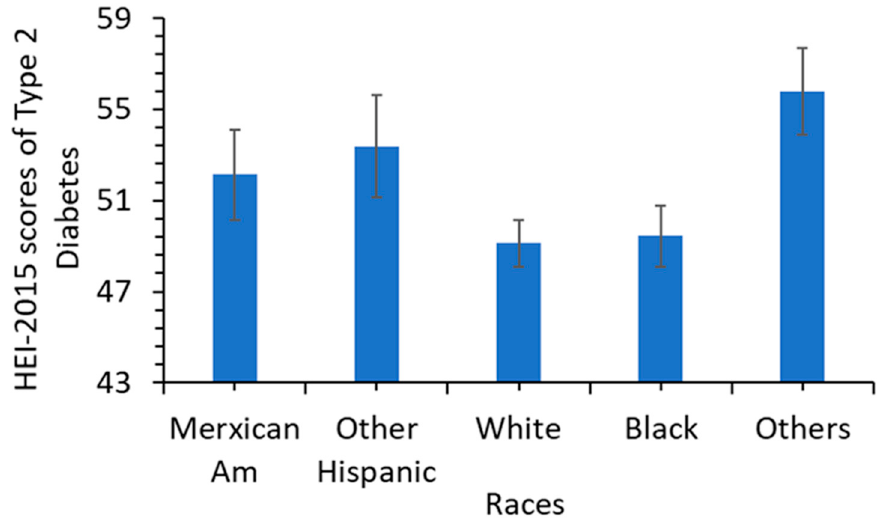
Figure 3. Total HEI-2015 scores of 5 races of US type 2 diabetic adults for 2017–2018. Table 2. Estimated means, their 95% CI, and trends of the total and component scores of Healthy Eating Index (HEI)-2015 of the US type 2 diabetic adults in NHANES survey cycles 1999–2018.